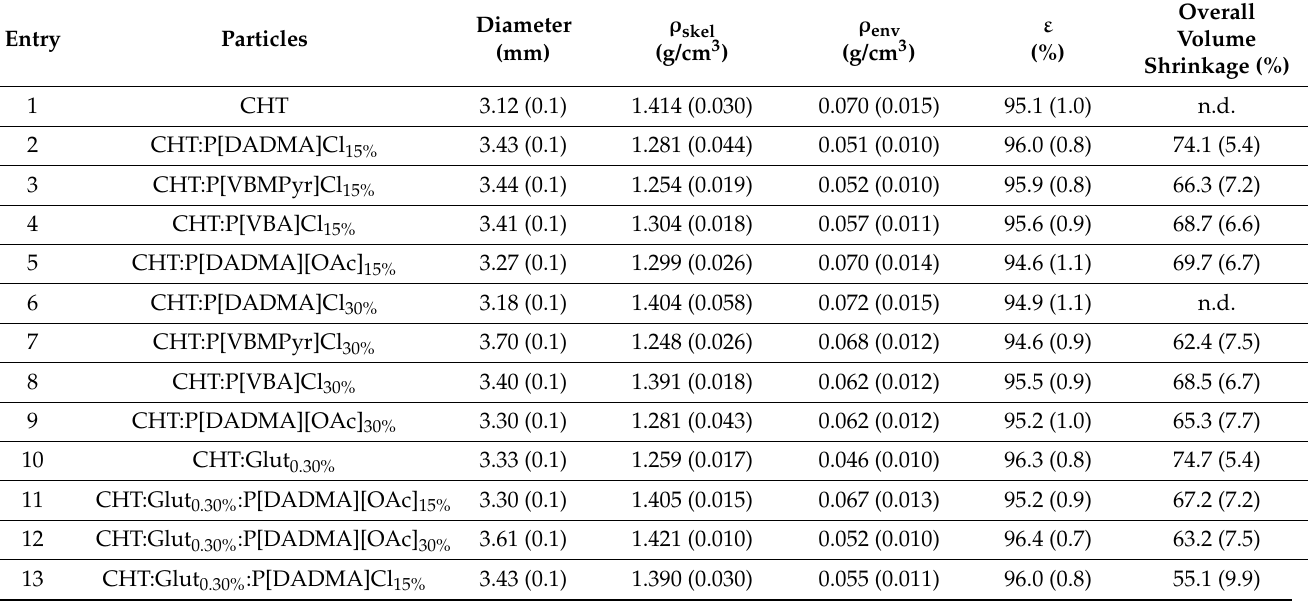
Table 2. Influence of PILs and cross-linker content in the chitosan gel beads on the physicochemical properties of the resulting chitosan aerogel particles. Notation: ρ skel , skeletal density (measured by helium pycnometry); ρ env , envelope density; ε , overall porosity. Values are expressed as mean followed by the standard deviation under parenthesis.